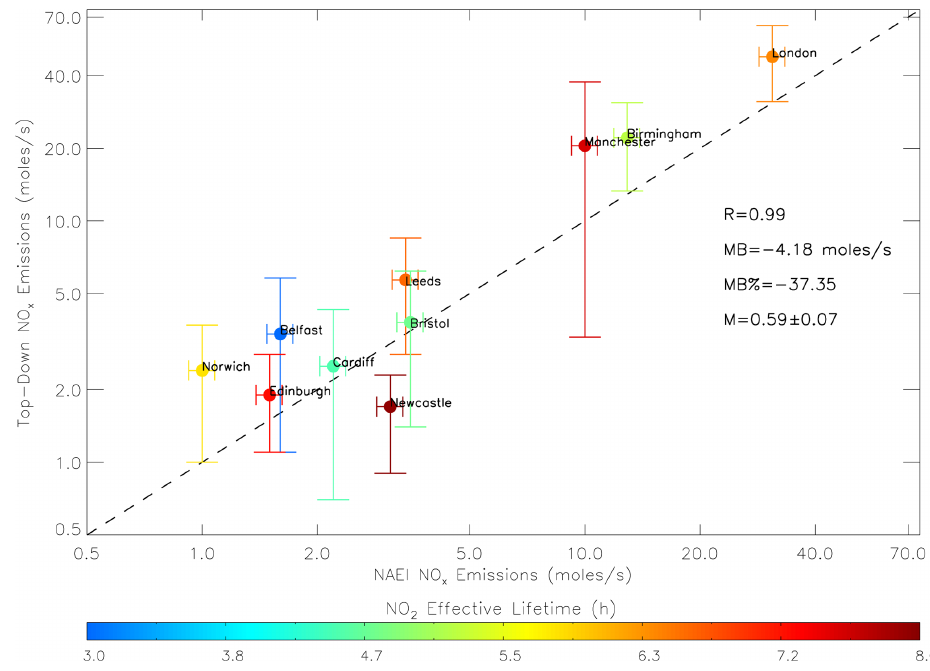
Figure 6. NAEI and top-down (TROPOMI) NO x emissions (mols − 1 ) for 10 UK cities coloured by the NO 2 effective lifetime (h). Where there is more than one top-down estimate for a city from multiple wind directions, the corresponding emission rates and lifetimes have been averaged together. The correlation ( R ), mean bias (MB, mols − 1 , i.e. NAEI-top down), percentage mean bias (MB%) and linear fit ( M , i.e. top-down vs. NAEI) are also shown. NAEI uncertainty is ± 7 . 8% (DEFRA, 2018b), and the top-down uncertainty range is based on the satellite errors. The black dashed line represents the 1 : 1 relationship, and both axes are on log